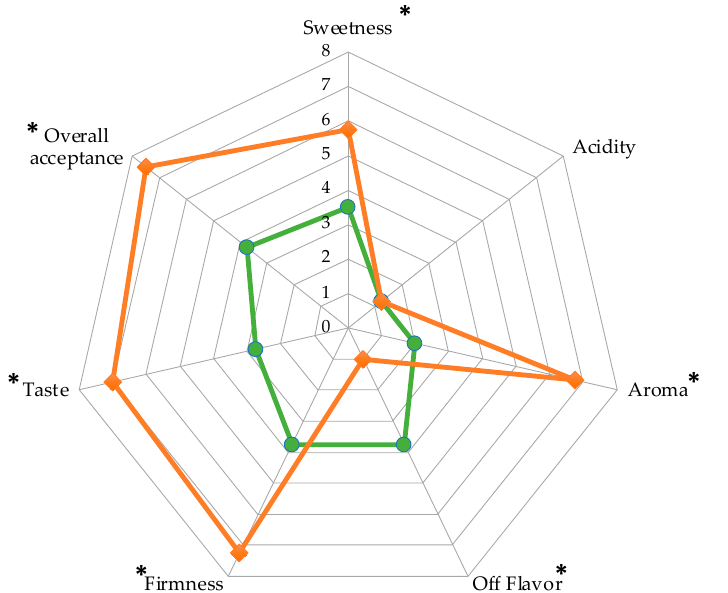
Figure 5. Sensorial analysis of minimally processed O. ficus-indica non-treated fruit (OFI C) and treated fruits with mucilage (OFI M) at the end of cold storage (9 days at 5 ◦ C.) * indicate significant differences (Tukey’s test at p ≤ 0.05) between the treatments (OFI C and OFI M, n = 5 ).